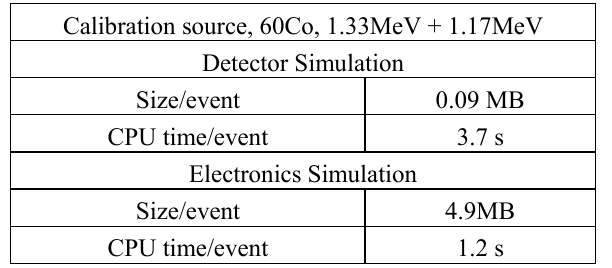
Table 1. Computing performance of simulation